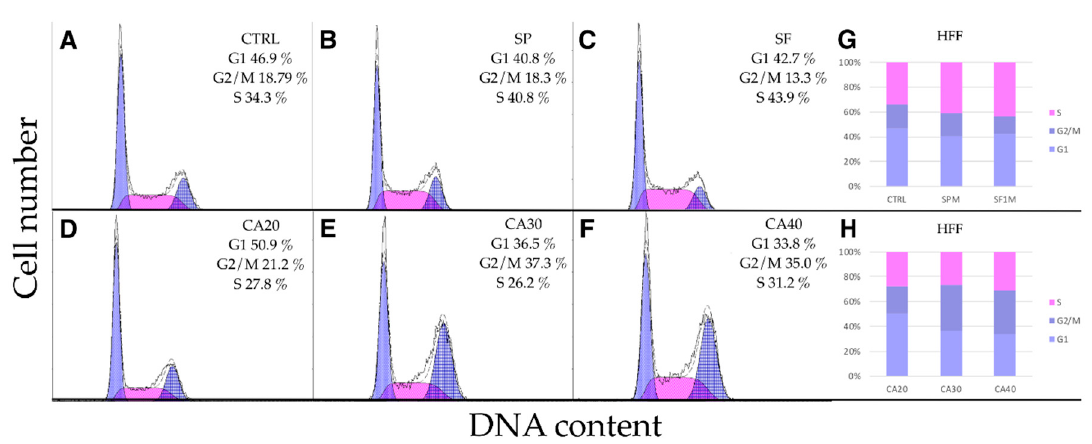
Figure 8. Cell cycle analysis of HFF cells. ( A ) Control DMSO treated cells. Cells treated 24 h with 100 µ g / mL of ( B ) SP, ( C ) SF methanolic extracts or ( D – F ) CA at concentrations of 20, 30 and 40 µ g / mL. ( G , H ) CA at concentrations 30 and 40 µ g / mL significantly increased the proportion of HFF cells in G2 / M phase.